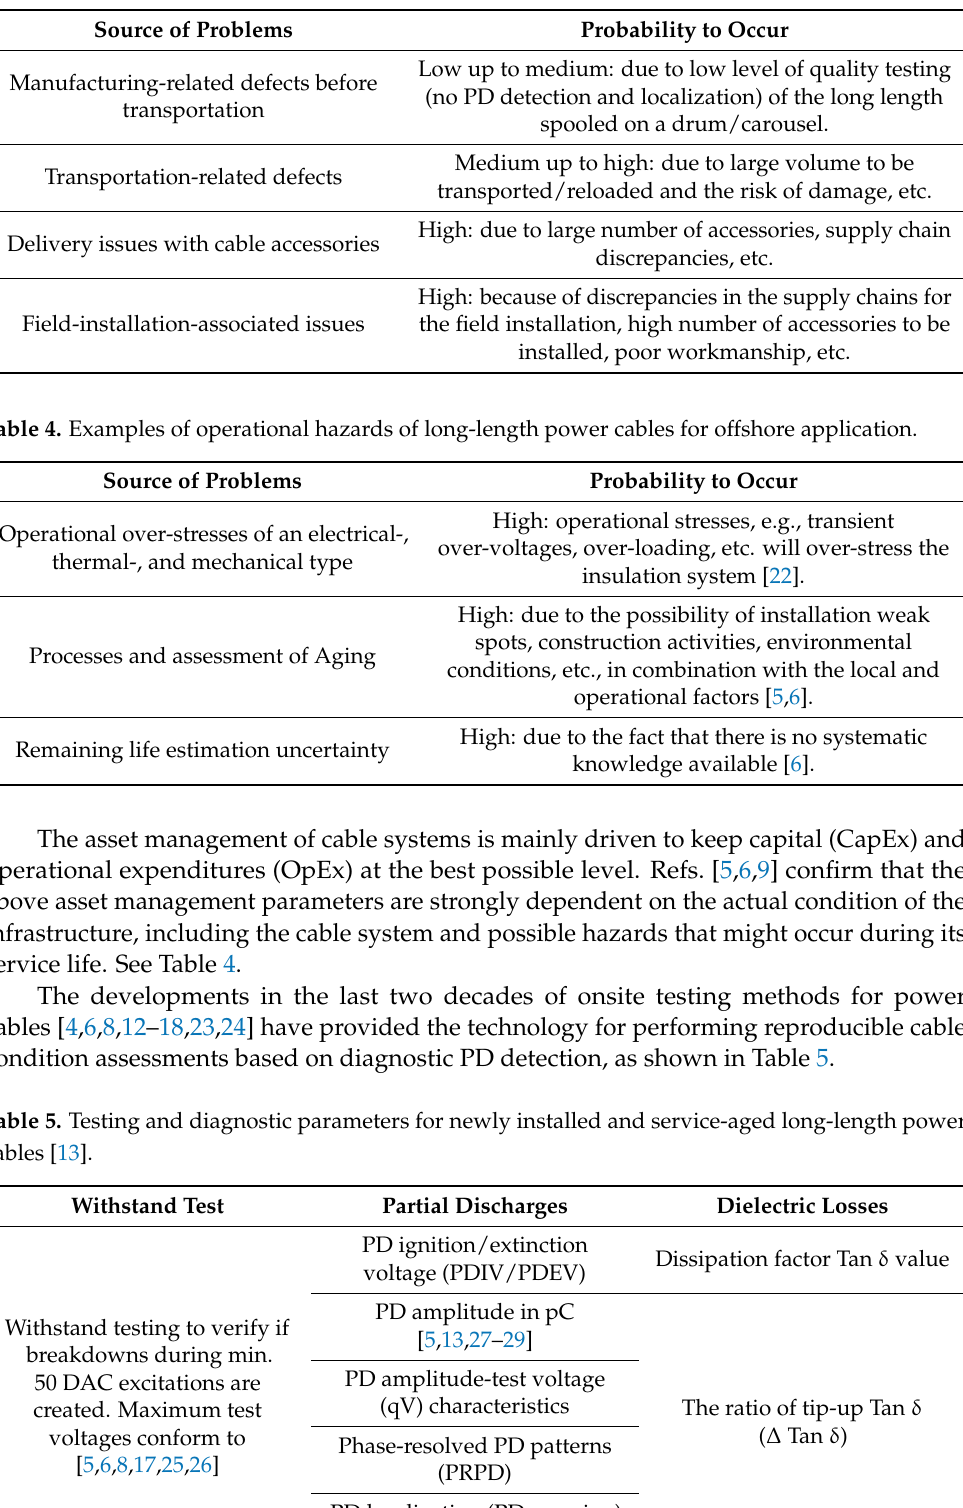
Table 3. Examples of needs of dedicated quality control of newly installed long-length power cables for offshore application.